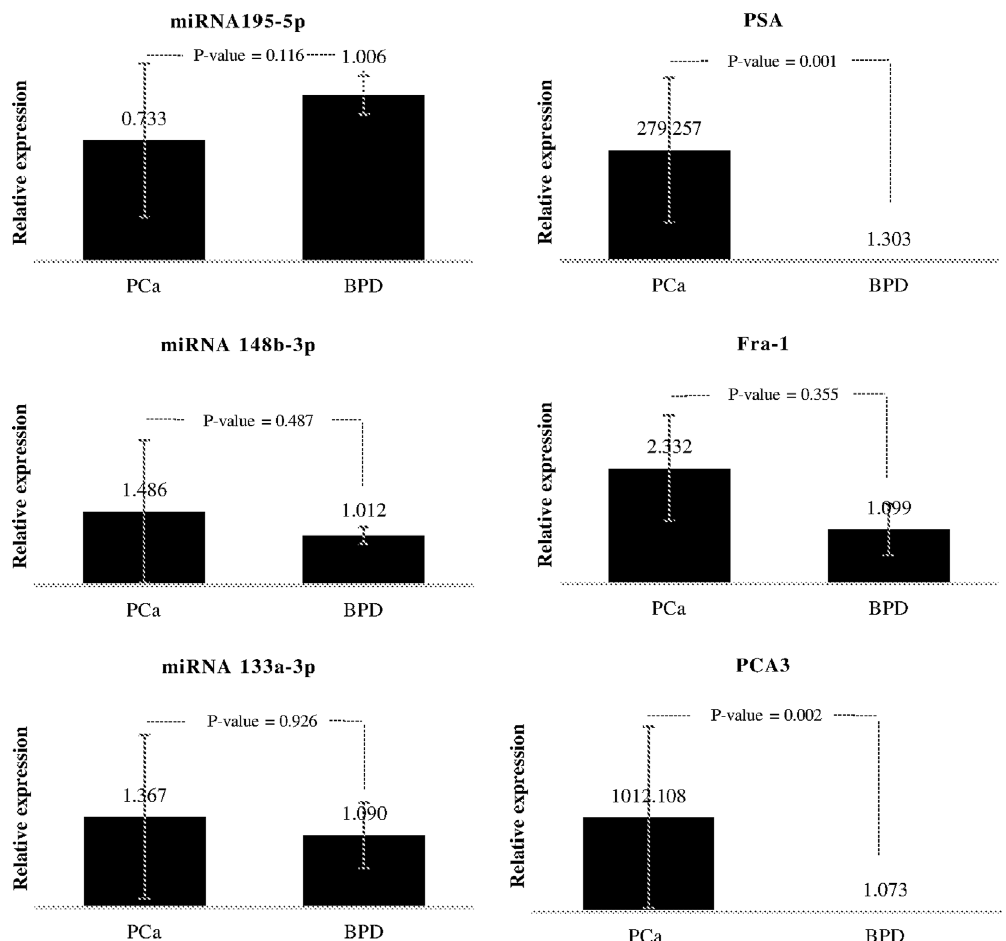
Figure 2 - Expression levels of miRNAs, PSA , PCA3 , and Fra-1 genes. Real-time PCR exhibited similar expression levels of the three miRNAs (left col- umn) and Fra-1 gene (mid-right) in PCa and BPD tissue samples. Expression levels of PCA3 (bottom-right) and PSA (top-right) genes were significantly higher in PCa than in BPD samples. Error bars indicate (cid:5)